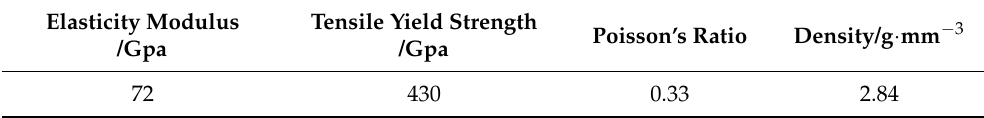
Figure 4. Blank and the design part. ( a ) Blank; ( b ) The design part. Table 1. Mechanical properties of aluminum alloy